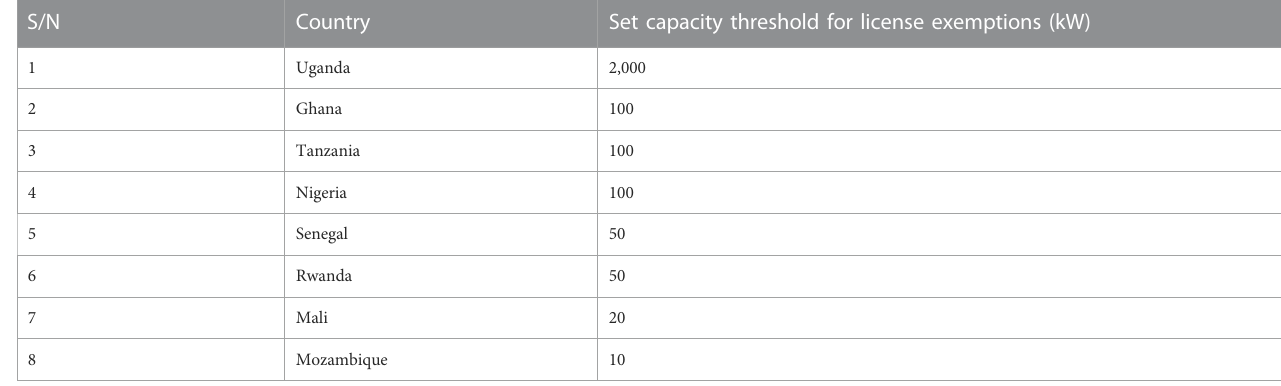
TABLE 10 Capacity thresholds of mini-grid operation with license exemption (Domegni and Azouma, 2022). S/N Country Set capacity threshold for license exemptions (kW)